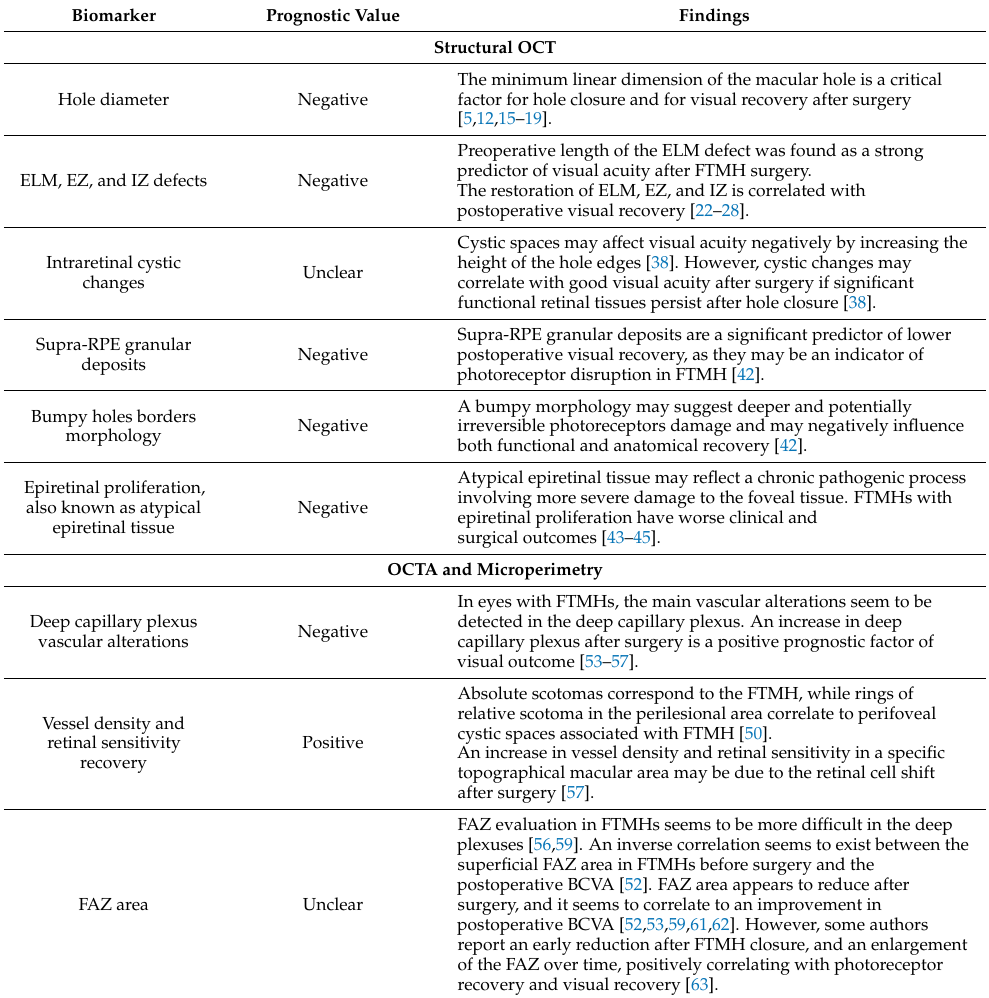
Table 2. Summary of key findings in full-thickness macular holes prognostic evaluation by means of different retinal imaging